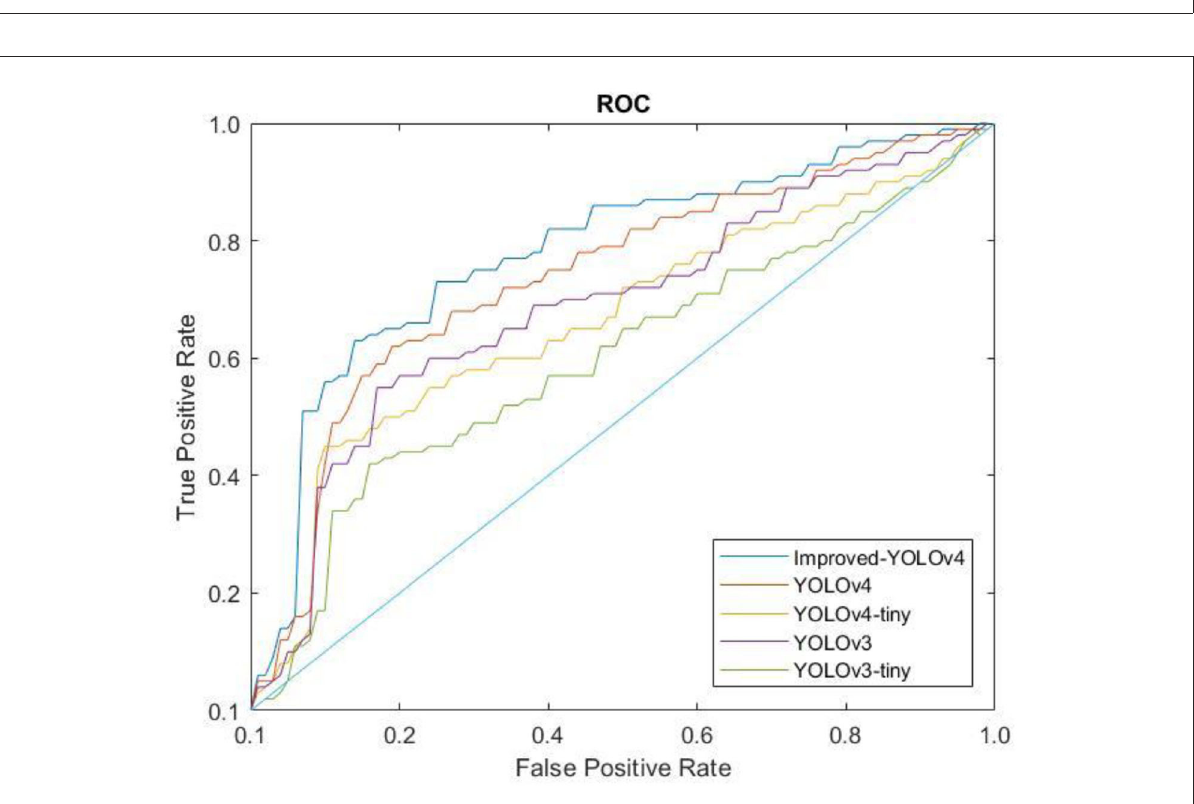
FIGURE13 The ROC curves of the proposed model and other